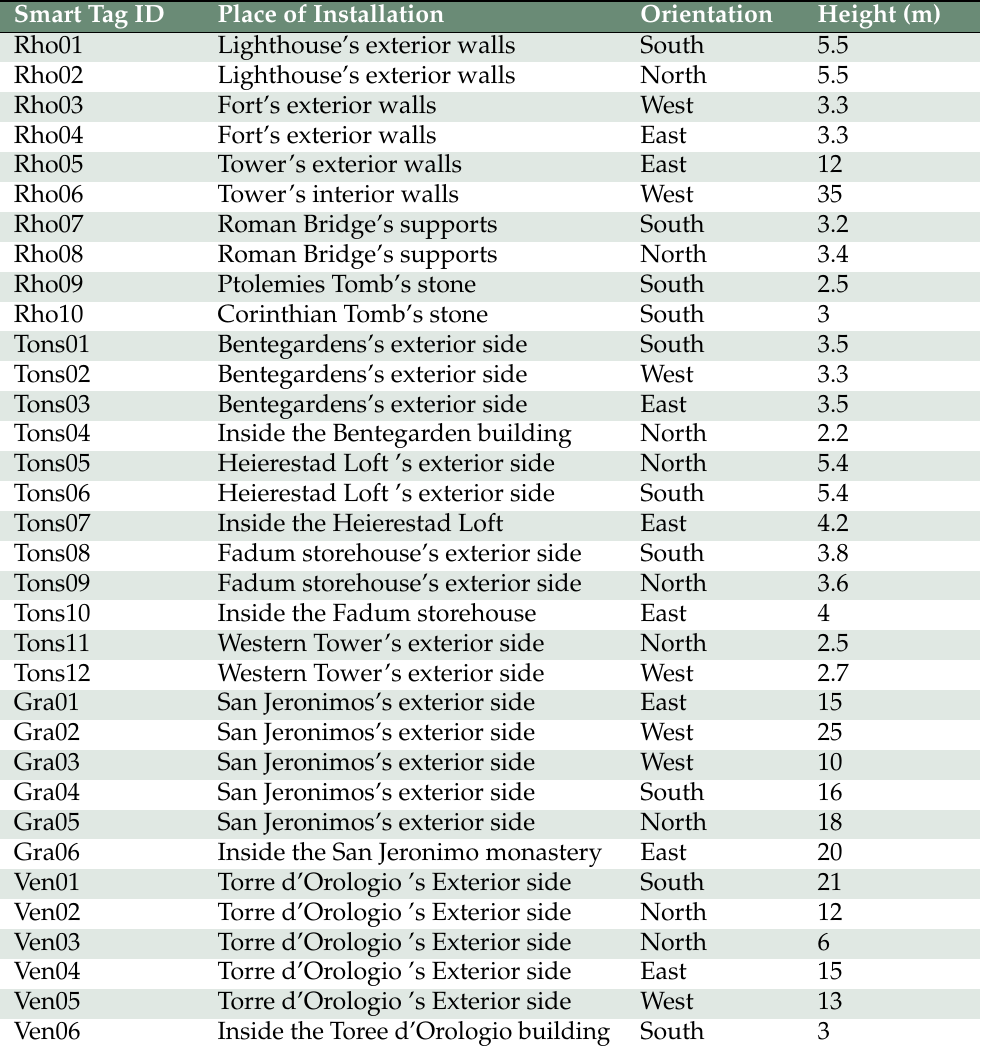
Table 4. The Smart Tags’ place of